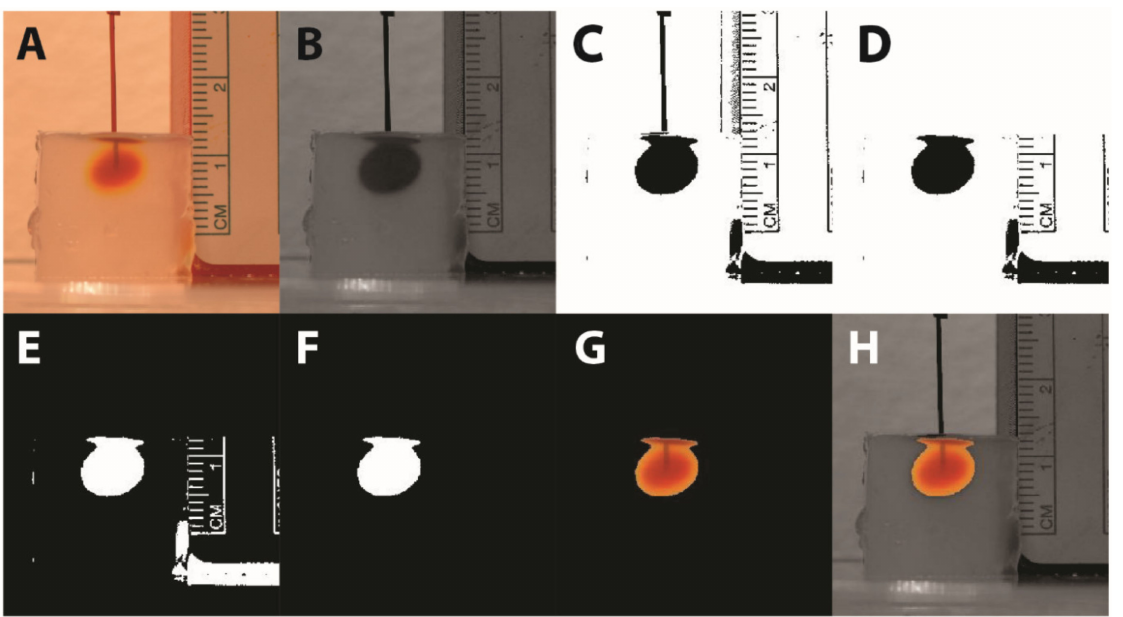
Figure 3. Image processing algorithm. ( A ) Original color image. ( B ) Single-color component image. ( C ) Thresholded image. ( D ) Cannula erasure. ( E ) Binary inversion. ( F ) Deletion of all non-bolus pixels. This is the final image used for volume calculation. ( G ) Color image of bolus overlaid on final image for user reference. ( H ) Color image of bolus overlaid on the single-color component image for user